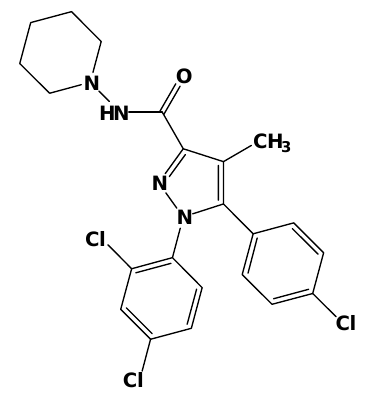
Figure 4. Rimonabant (SR141716, 14